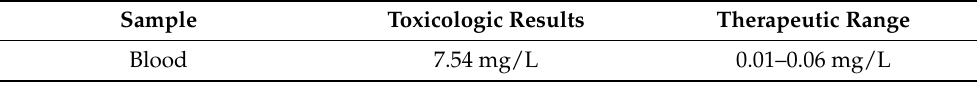
Table 1. Results of quantitative analysis positive for bisoprolol in blood sample, compared to the therapeutic